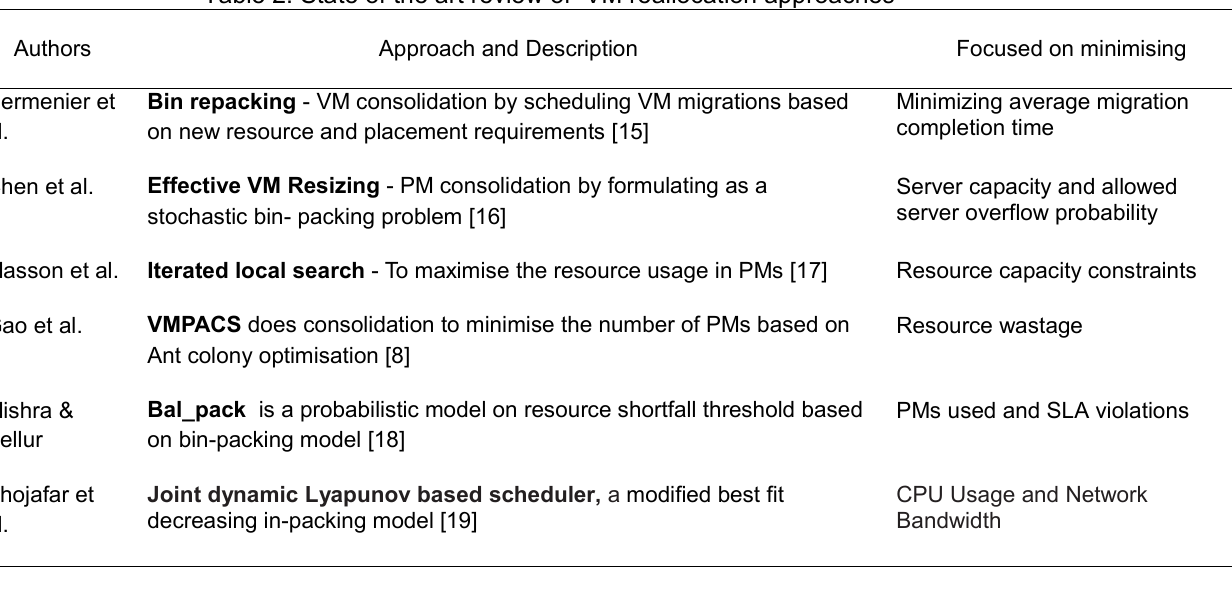
Table 2. State of the art review of VM reallocation